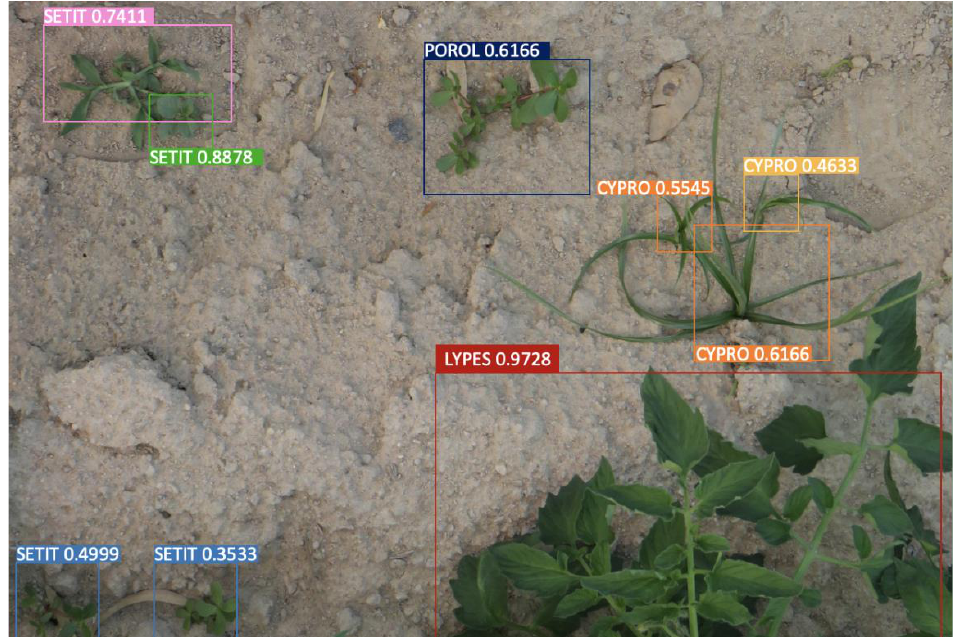
Figure 4. Example of weed detection through RetinaNet with bounding boxes with the confidence level.